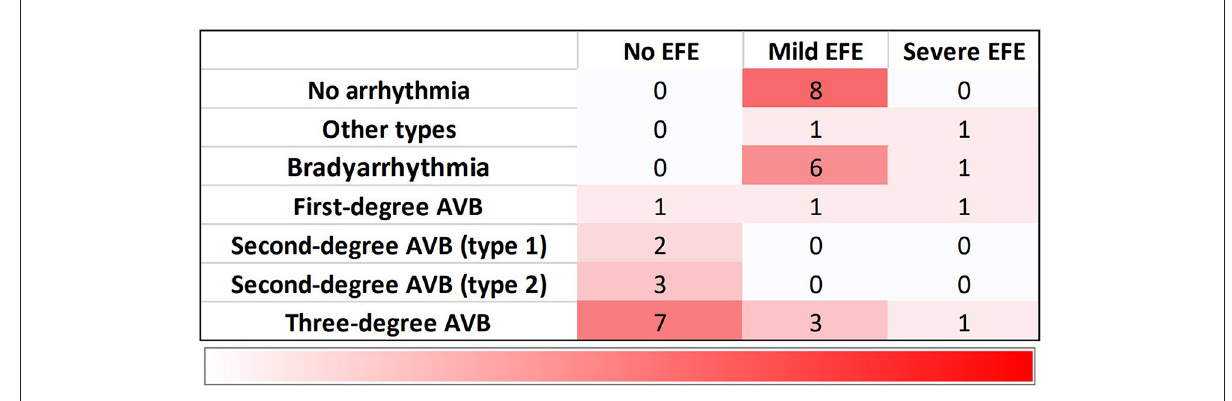
FIGURE3 Distribution of 36 fetuses with cardiac manifestations due to maternal anti-Ro and anti-La antibodies. Bradyarrhythmia includes sinus bradycardia, junctional rhythm and ectopic atrial rhythm. Other types contain ventricular tachycardia and atrial flutter. EFE, endocardial fibroelastosis; AVB, atrioventricular block.